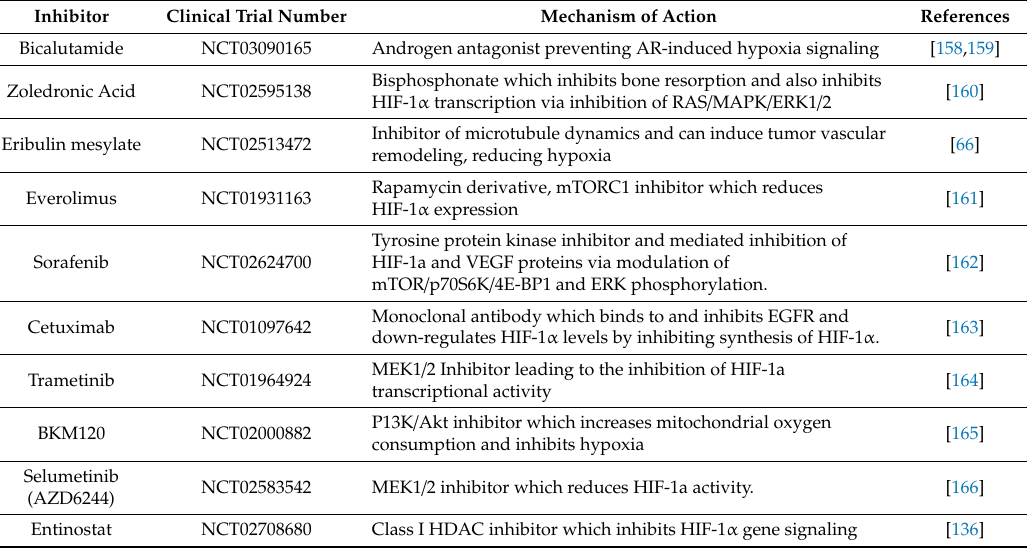
Table 4. Potential Hypoxia Inhibitors Used in Active TNBC Clinical